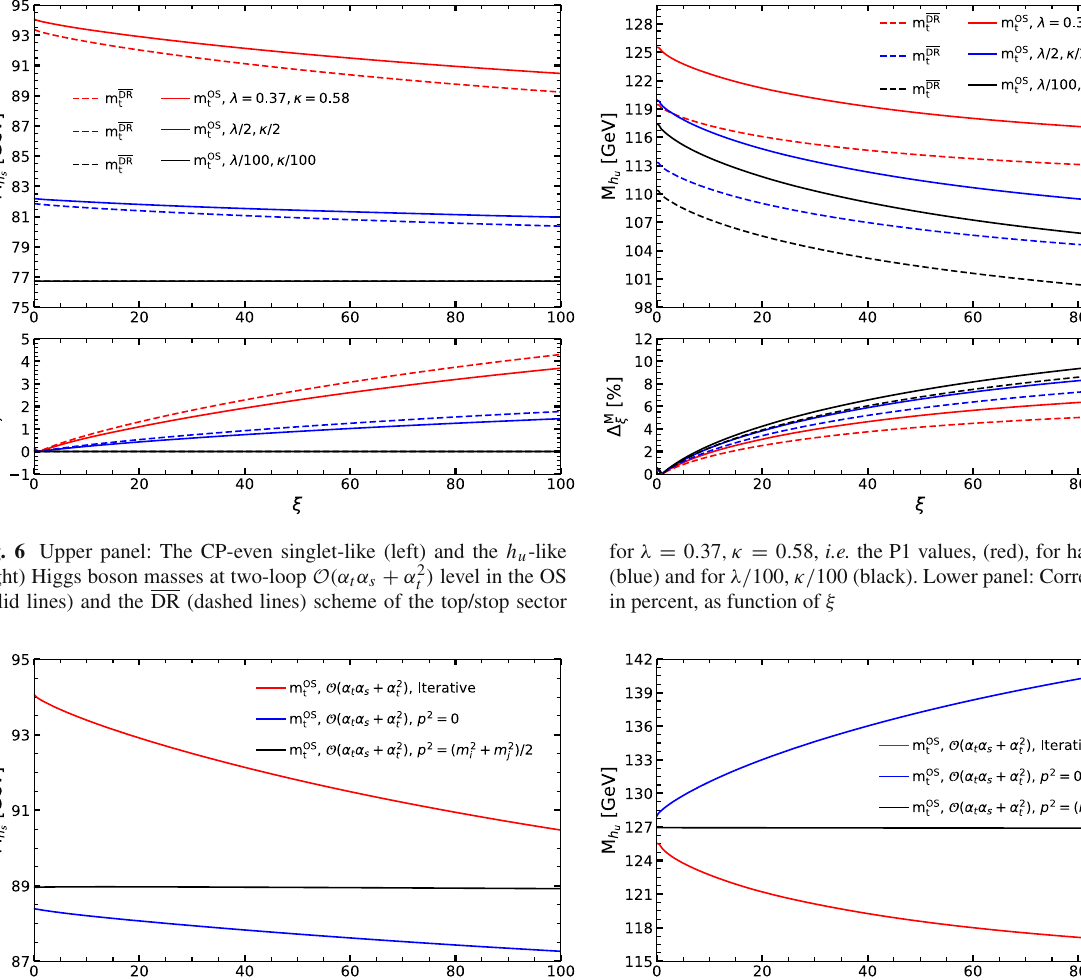
and the R mtree -method (black). See text, for explanations. Lower panel: Corresponding (cid:15) M ξ in percent, as function of